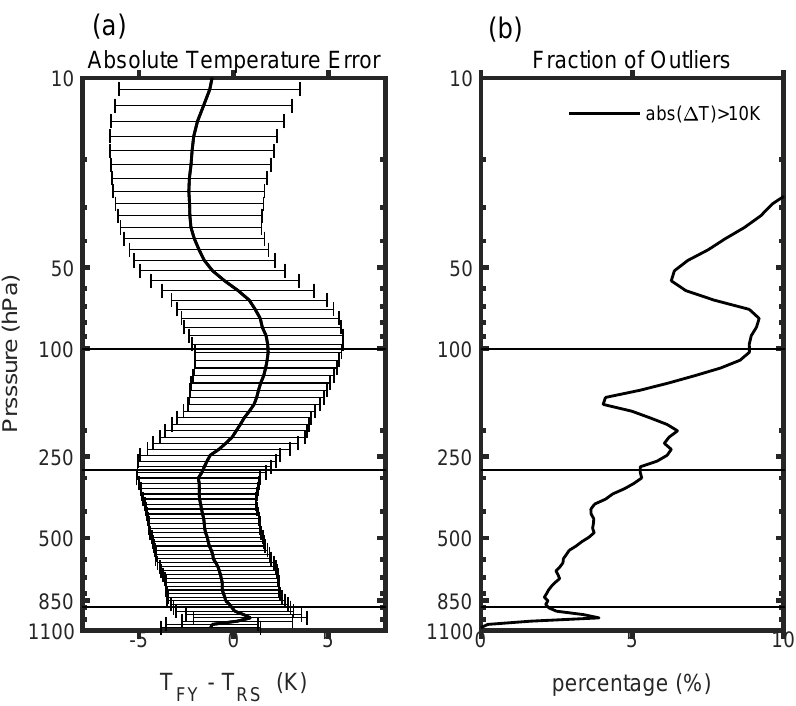
Figure 3. ( a ): The vertical distribution of the average biases and uncertainties. According to the trend of the bias and the conventional layers in the atmosphere, the profiles are divided into four parts. 1: from the surface to 900 hPa, represents the situation in the planetary boundary layer (PBL). 2: from 900 hPa to 300 hPa. Mostly are the troposphere layer, 3: 300 hPa to 100 hPa, the tropopause layer, most of the tropopause are in this layer; 4: 100 hPa to 10 hPa, which represent the stratosphere layer. ( b ): the fractions of outliers of the temperature, the definition of the outlier is that the difference between the FY4A measurements and radiosonde measurements is higher than 10